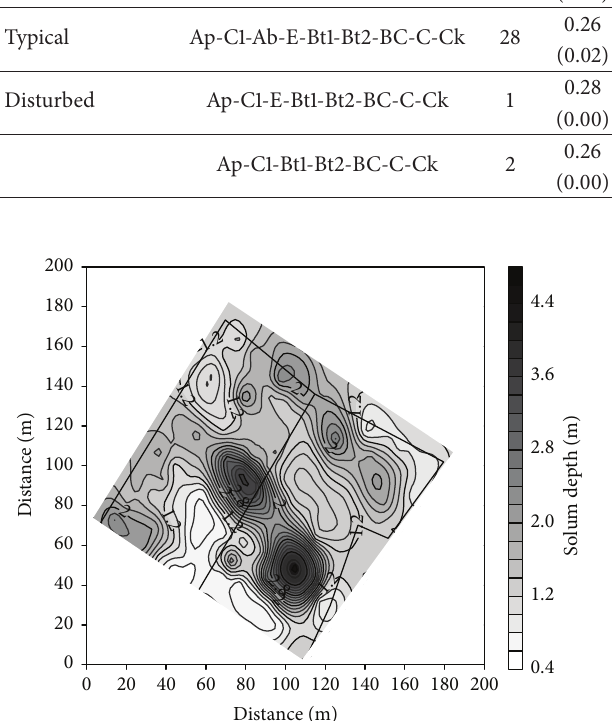
Figure 3: Distribution of soil solum